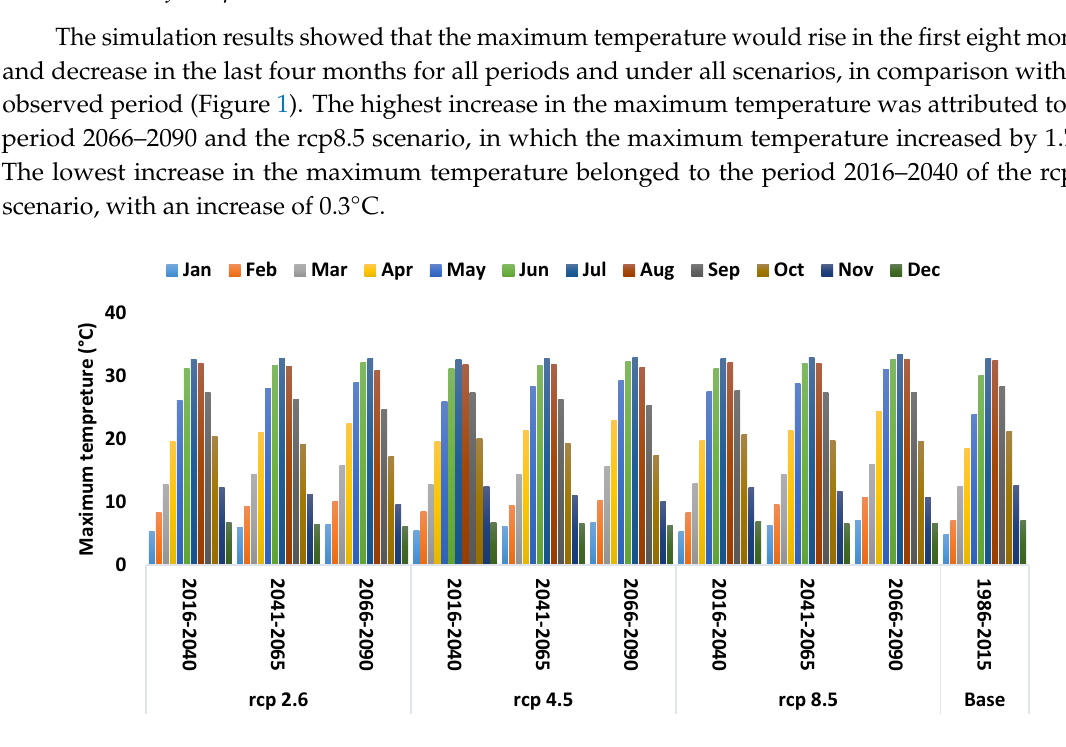
Figure 1. Comparison of the mean monthly maximum temperature of periods 2016–2040, 2041–2065, and 2066–2090 under scenarios rcp2.6, rcp4.5, and rcp8.5 with the baseline period.